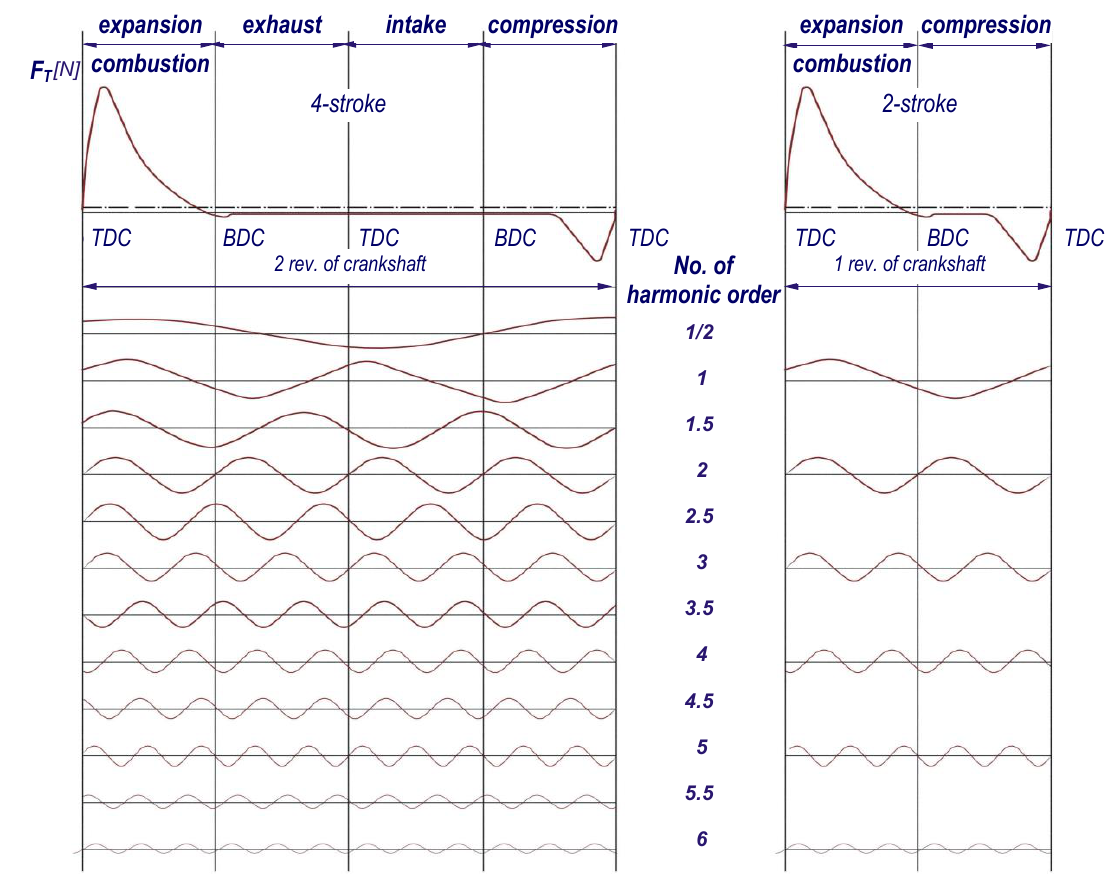
Figure 2. The course of the tangential force F T and its successive harmonics in a four- and two-stroke engine [7,8].